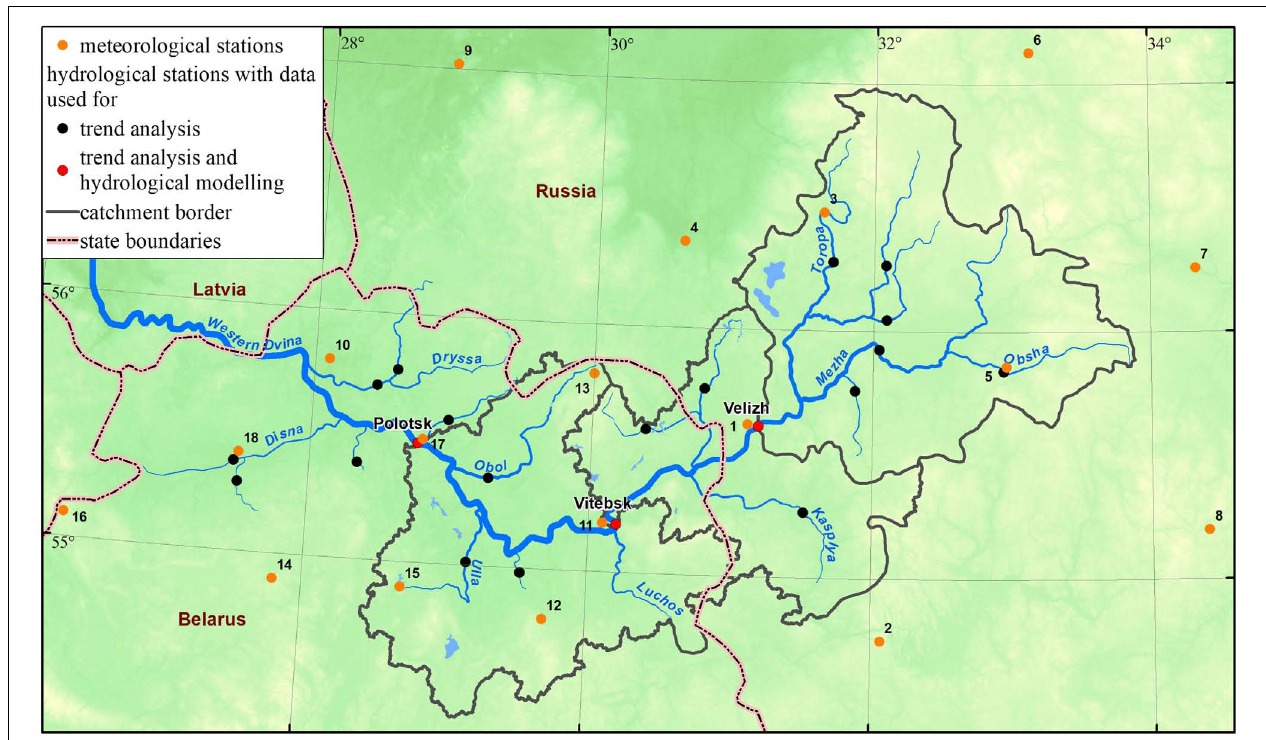
FIGURE 2 | Stations in the Western Dvina River Basin with instrumental observations of meteorological and hydrological characteristics.